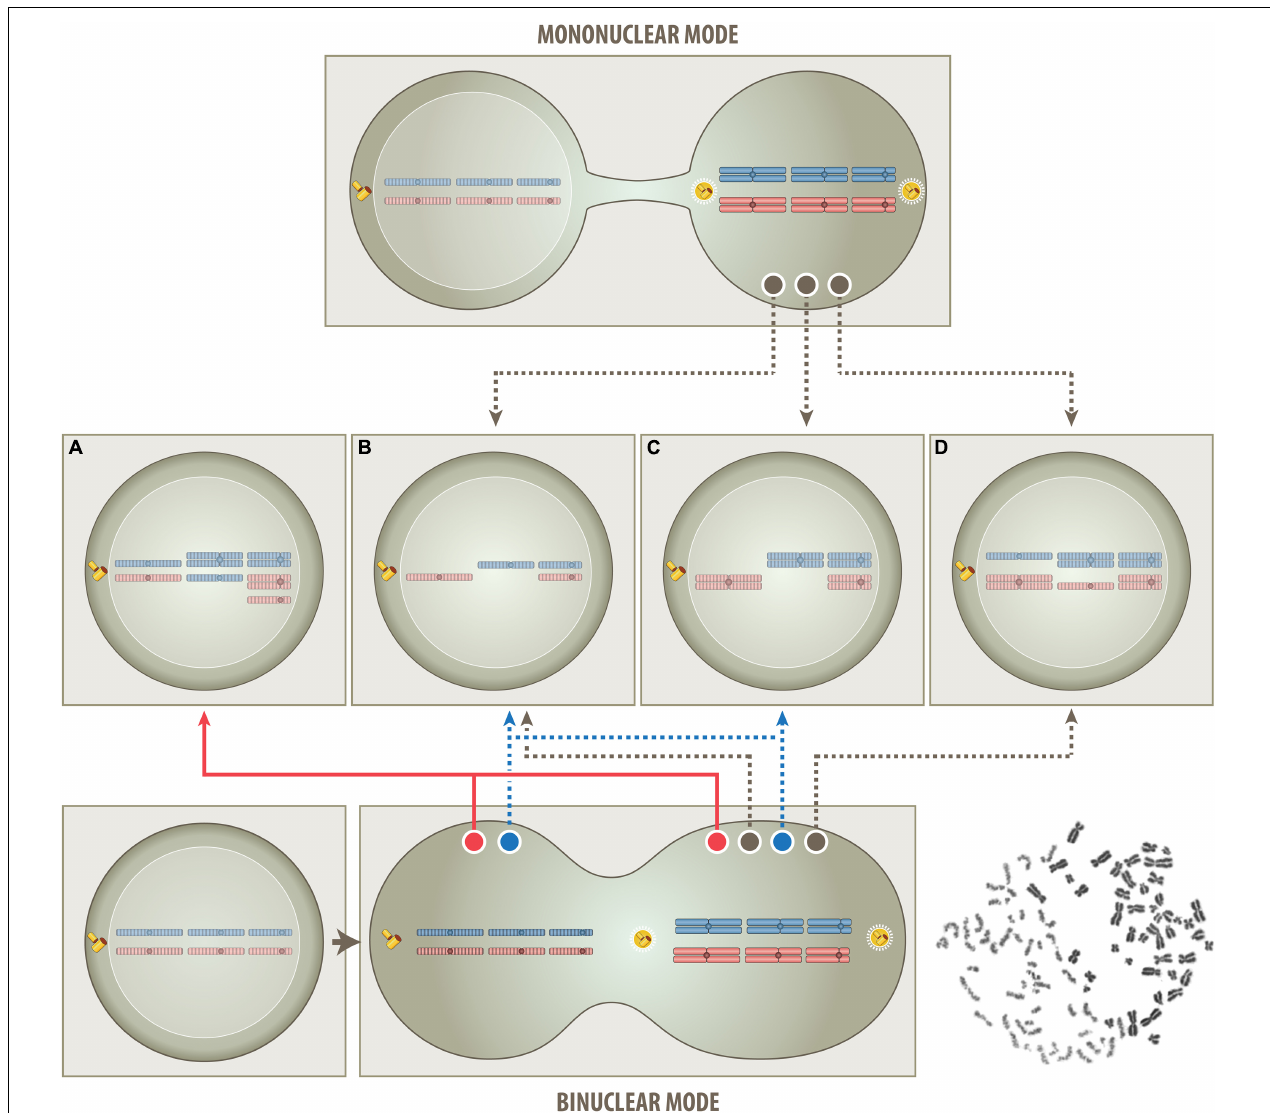
FIGURE 2 | Schematic outline of the proposed one step routes that produce either a mononuclear- or binuclear-derived aneuploidy (MNDA & BNDA). In the mononuclear route (top part), all superfluous chromosomes derive solely from a single (tetraploid) mitotic cell. This model postulates that the untimely cytoplasmic influx from a non-dividing G0/G1 cell will disturb the phase separation and condensation process of various components of the cell division machinery (Ong and Torres, 2020) and thereby cause chromatid segregation and nondisjunction errors. The consistent heterozygous “2 + 2” pattern is not only a clear indication that tetrasomies always derive from both chromatids of a particular pair of metaphase chromosomes but, at the same time, also that they are the crucial and indispensable survival factor, since corresponding twin cells will lack both homologs and can therefore not survive. In case of BCP-ALL, for instance, the respective survival factor is a tetrasomy 21 (Paulsson and Johansson, 2009) and in case of oncocytic forms of thyroid carcinomas a tetrasomy 7 (Corver et al., 2012). Apart from the consistent occurrence of such “2 + 2” tetrasomy patterns, the mononuclear mode is consistent with and can therefore also easily explain all other patterns and combinations of chromosomes, as long as they only comprise between one and four copies and not more than two homologs of either one, i. e., monosomies, heterozygous di-, tri- and tetrasomies as well as homozygous (“uniparental”) disomies (B–D) . Of special note in this context is the unique form of hyperdiploidy that only consists of homozygous disomic and heterozygous tetrasomic chromosomes ( C and Figure 3 , left). According to the hitherto generally uphold view such patterns can only arise in consecutive steps that eventually duplicates an afore generated hyperhaploid (B) genome. Following this logic, such peculiar hyperdiploid patterns are therefore considered as a surrogate proof for the necessary existence of an originally hyperhaploid predecessor clone, irrespective of whether it can indeed be identified or not. The herein proposed tetraploid mitotic aneuploidization route, on the other hand, provides a plausible alternative explanation for how such hyperhaploid (B) or hyperdiploid (C) clones can derive from a single mitotic cell even in a single step. However, it also precludes that they can coexist in this particular setting since they cannot be produced simultaneously. Although this mononuclear route is very similar to the previously propagated tetraploid one, it differs in two important aspects, namely in the way the segregation of chromatids is affected and that only a single pair of centrosomes is operative and responsible for their subsequent allocation to daughter cells. During mitosis diploid cells become temporarily tetraploid, i.e., they contain 92 chromatid chromosomes and two functional centrosomes. Genuine tetraploid cells, on the other hand, may derive from diploid ones through endoreduplication, endomitosis or cell fusion, and therefore contain double the number of chromatids, chromosomes and centrosomes. They are a frequent transitory state on the route to aneuploidy and, once formed, can undergo either bipolar,